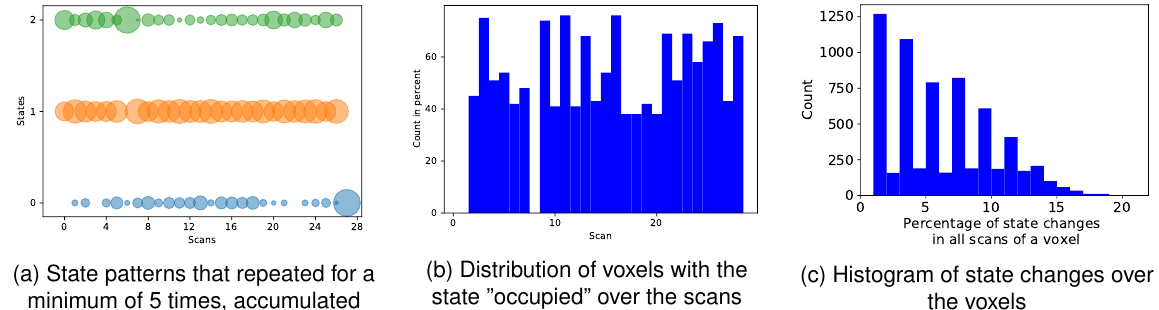
Figure 11. Pattern distribution for a building facade.